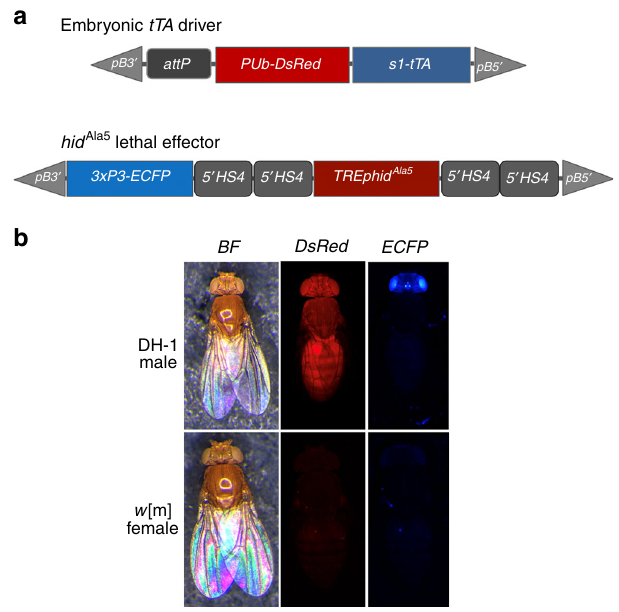
Fig. 1 The tTA driver and lethal effector piggyBac vectors and phenotypes of a DH-1 male and w [m] female. a Structure of the pBXL{ attP_PUbDsRed. T3_fa_s1-tTA_a } tTA driver and pBac{ 3xP3-ECFP af; 5 ’ HS4 > 5 ’ HS4 > TREp- hid Ala5 > 5 ’ HS4 > 5 ’ HS4 } lethal effector vectors in the double-homozygous line, DH-1. b Images of an adult DH-1 male and w [m] female under bright fi eld (BF) and Texas Red (DsRed) and CFP (ECFP) epi fl uorescence optics. DH-1 males, having a w [m] background, exhibit the white - eye phenotype under bright fi eld and whole-body PUbDsRed and eye-speci fi c 3xP3-ECFP fl uorescent markers for the driver and effector vectors, respectively. Non-transgenic w [m] females exhibit the white - eye phenotype under bright fi eld and are non- fl uorescent for both